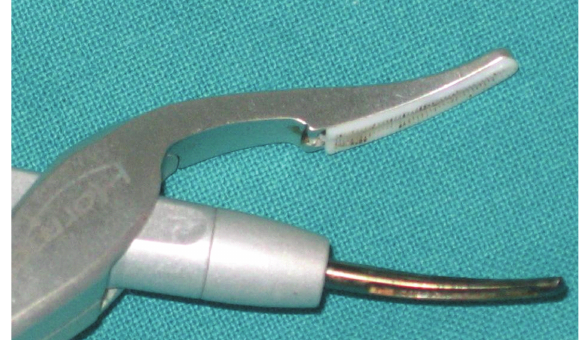
Figure 2: The curved blade and the clamp arm with Teflon pad of the Focus Ultracision Harmonic Scalpel used in otolaryngologic surgery.